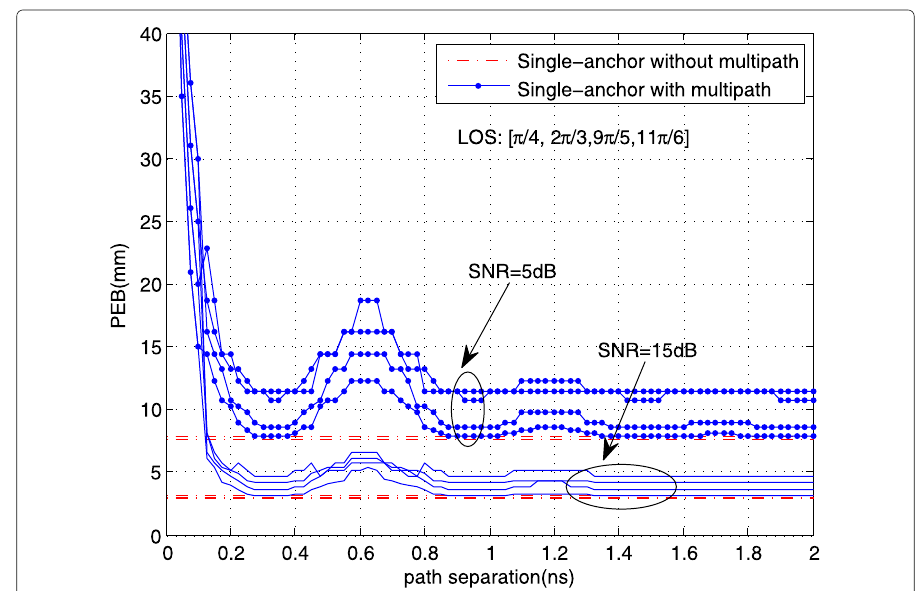
Fig. 10 PEB of single anchor localization without cooperation, as a function of path separation, where different SNRs are considered